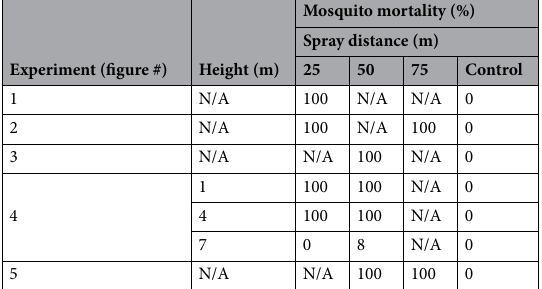
Experiment (figure